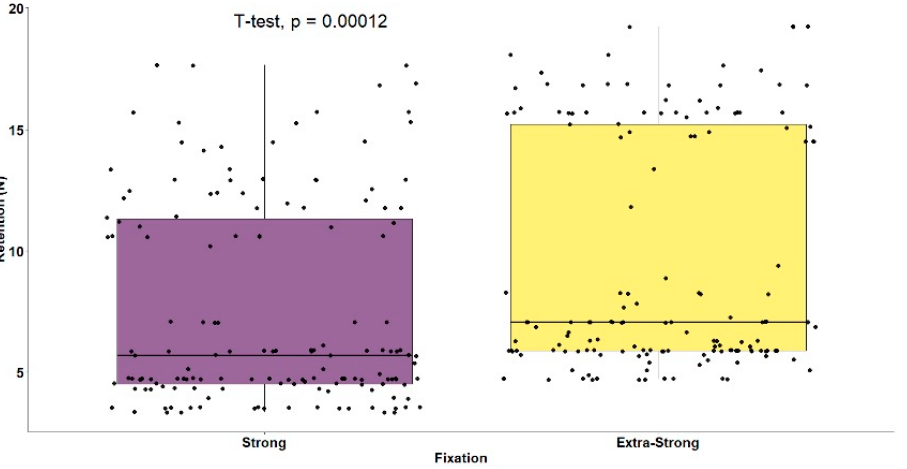
Figure 7. Boxplots for comparing adhesive retention by type of fixation.